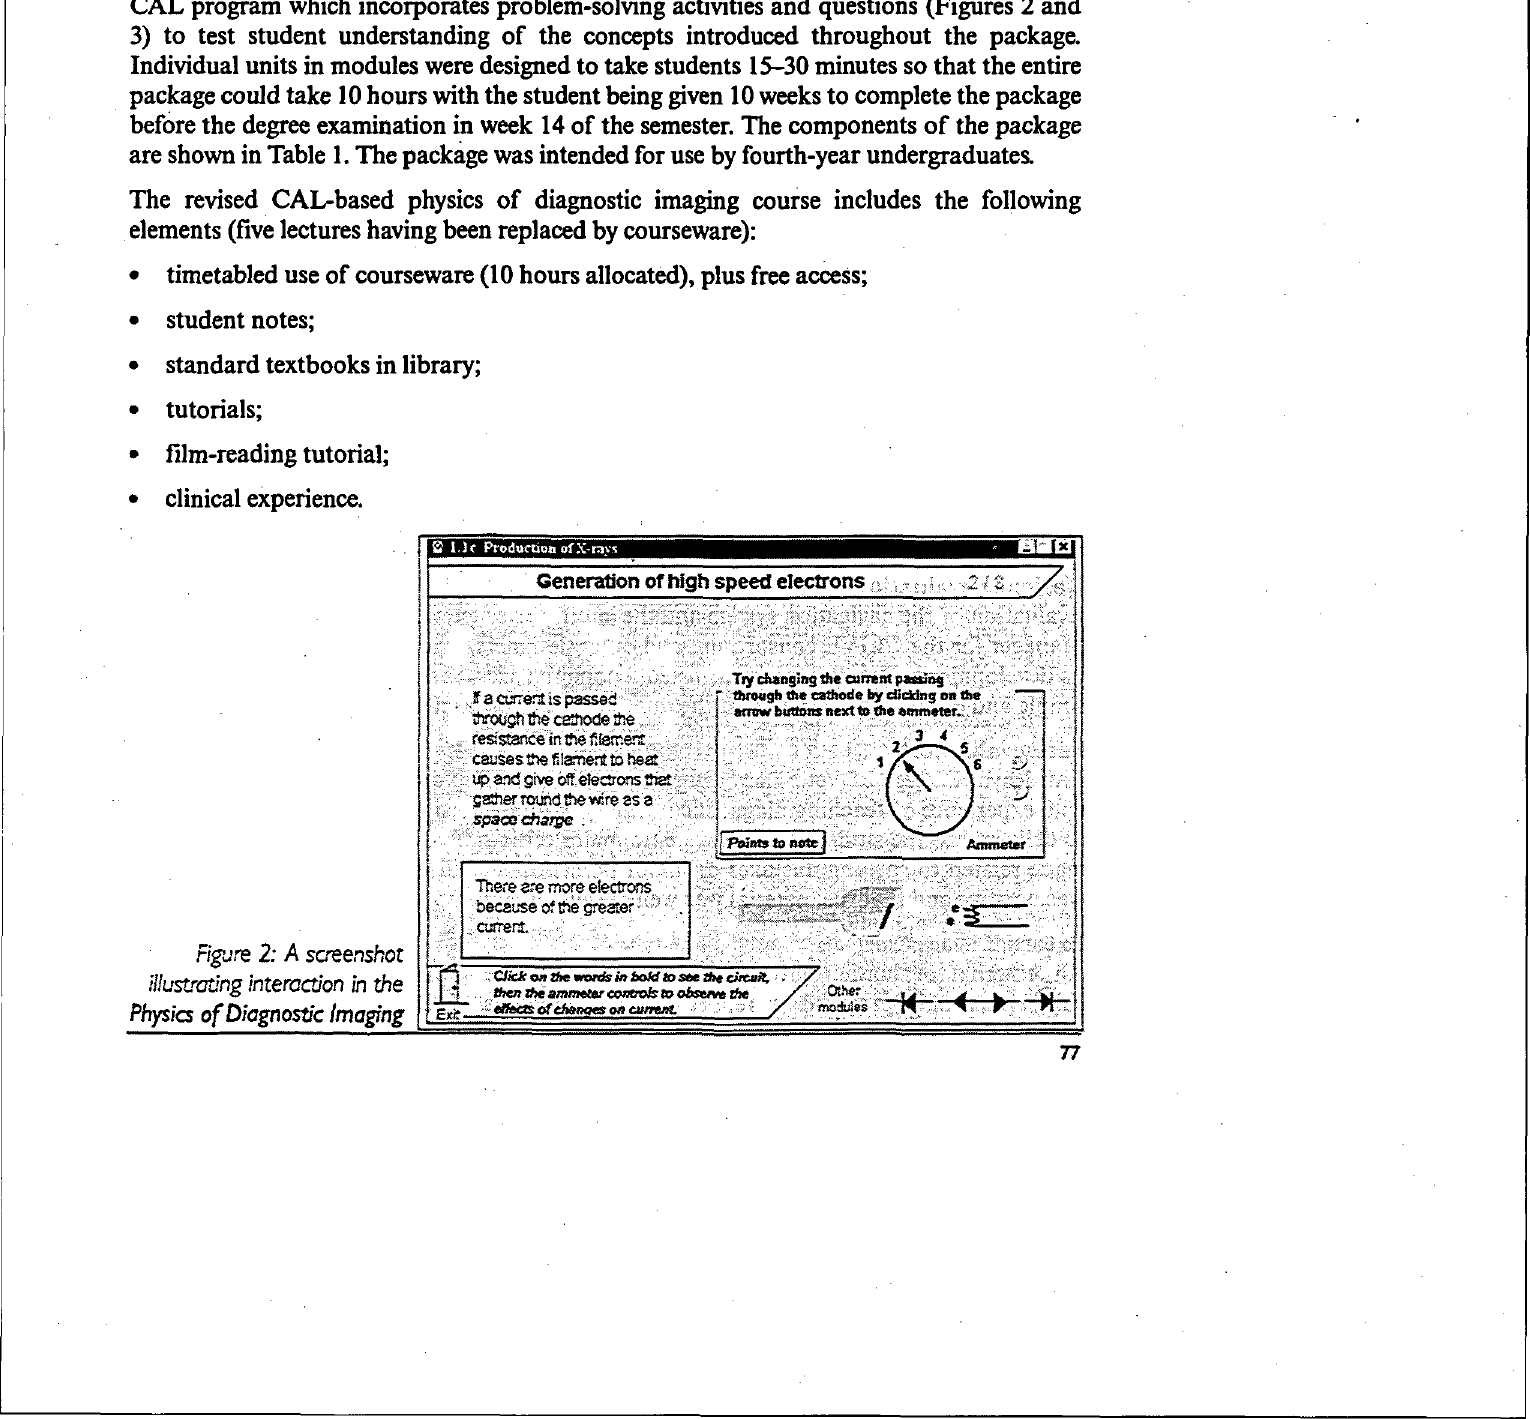
Figure 2: A saeenshot illustrating interaction fa the Physics of Diagnostic imaging